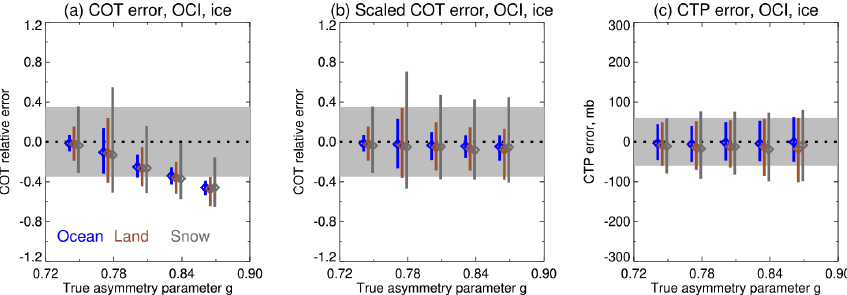
Figure 14. Retrieval error as a function of ice crystal asymmetry parameter, for OCI, for the case where cloud phase is known beforehand. Blue, brown, and grey indicate ocean-like, land-like, and snow-like simulations, slightly offset from one another horizontally for clarity. From left to right, panels show COT, asymmetry-corrected COT (Sect. 3.3.2), and CTP. Grey shading indicates the PACE mission goal uncertainties: 35% for ice-phase COT and 60mb for CTP (the latter for COT ≥ 3 only). The dotted line indicates an error of